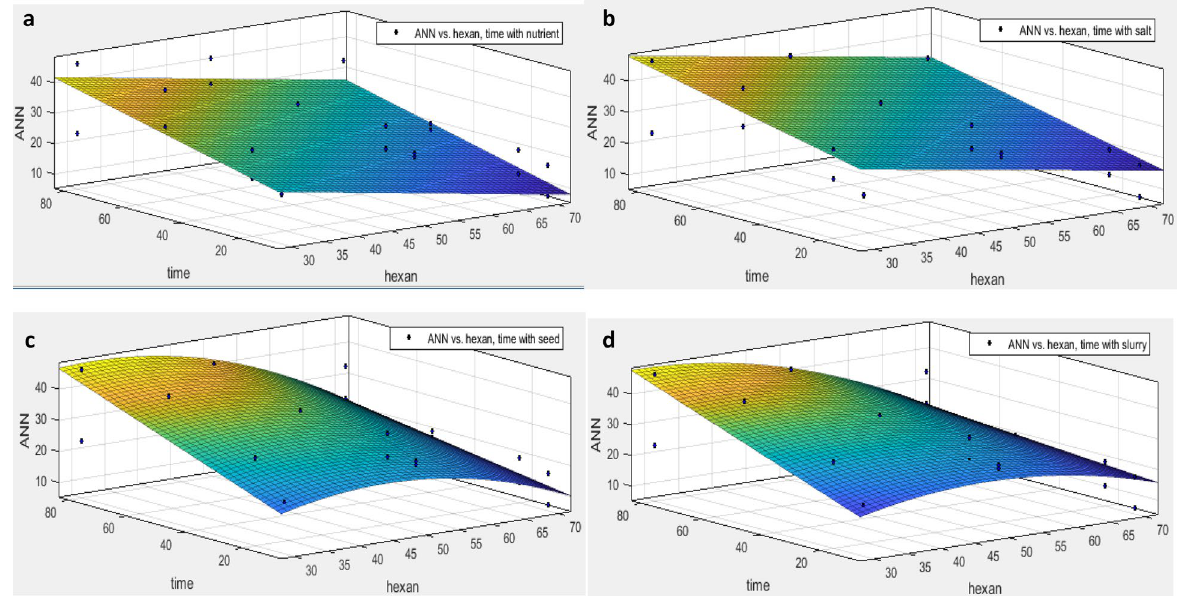
Figure 6. The effect of exposure time and initial hexane concentration on hexane removal perxent by ANN modeling. ( a ) the presence of nutrient, ( b ) the presence of microbial salt, ( c ) the presence of seed and d) the presence of slurry, by excel version 2013 software.